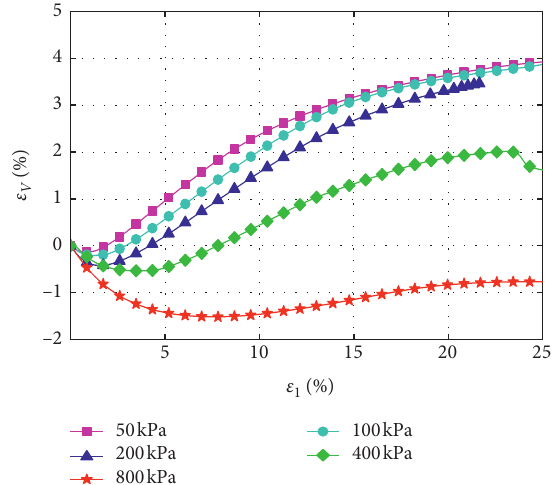
Figure 13: The relationships of ε